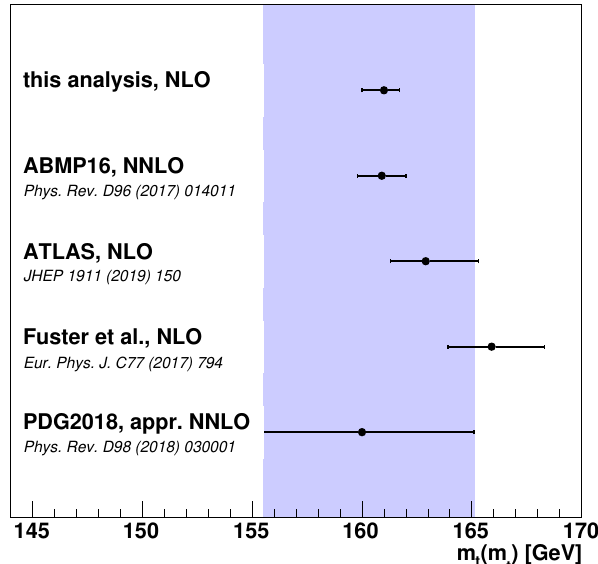
Figure 18 . The extracted value of m t ( m t ) compared to other determinations [23, 40, 41, 49]. The world average labelled as ‘PDG2018, appr. NNLO’ is based on a single determination of the D0 collaboration